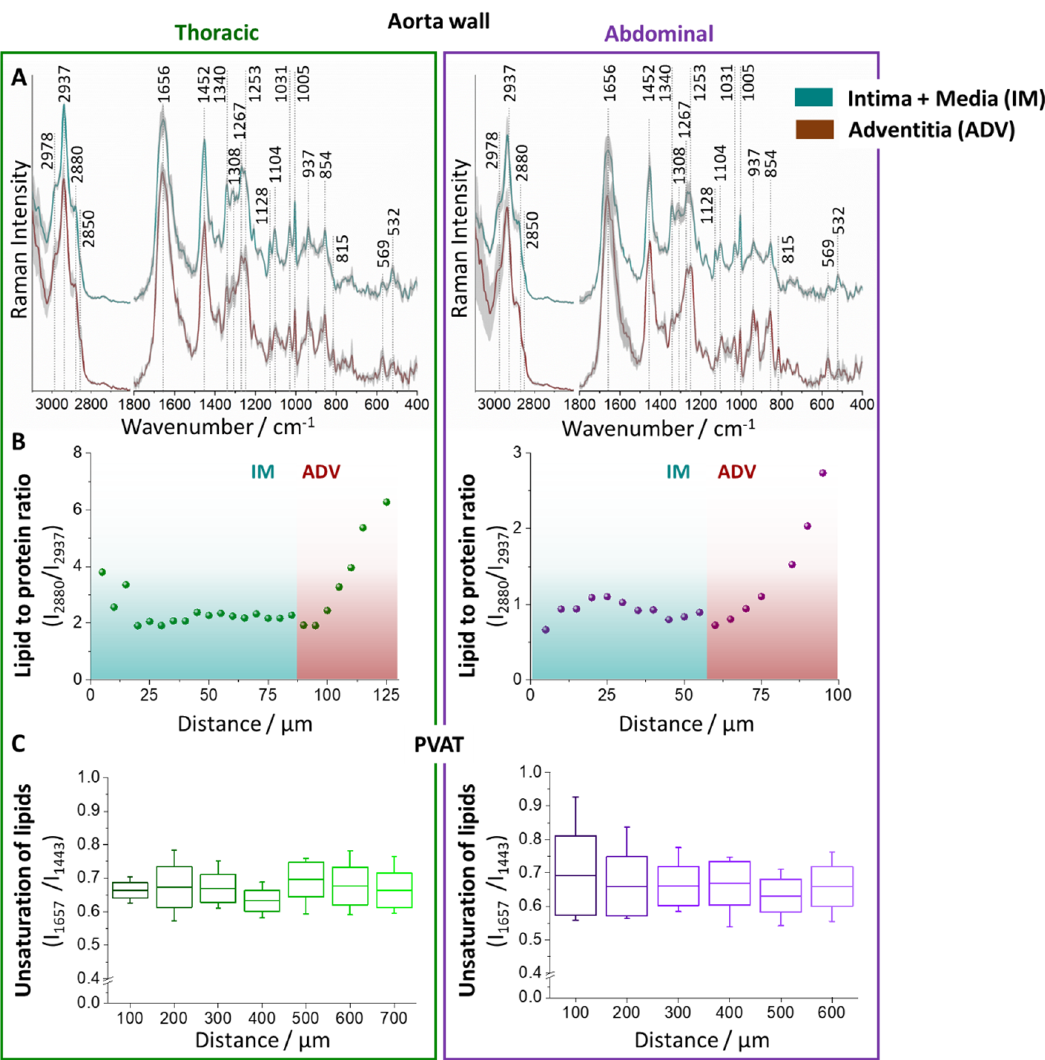
Figure 2. Aorta wall and PVAT chemical characteristics. The average Raman spectra ( A ) and the lipid and protein alterations along the aorta cross section ( B ) in intima and media (IM), and adventitia (ADV) layers of the vessel wall of thoracic and abdominal aorta. The analysis of lipid unsaturation degree of PVAT ( C ). Values given as mean ± SEM are shown in box plots: mean (horizontal line), SEM (box), minimal, and maximal values (whiskers).